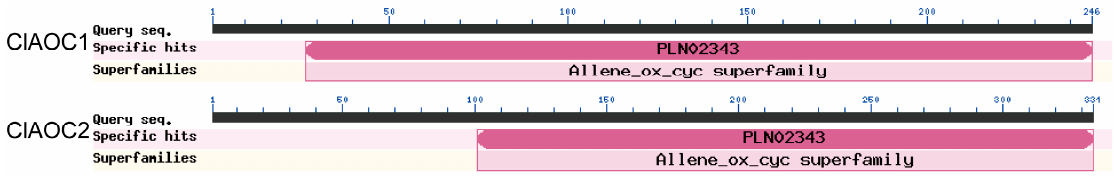
Figure 1. Domain analyses of the putative ClAOC1 and ClAOC2 proteins. Table 1. The basic characterizations of ClAOC genes in watermelon.